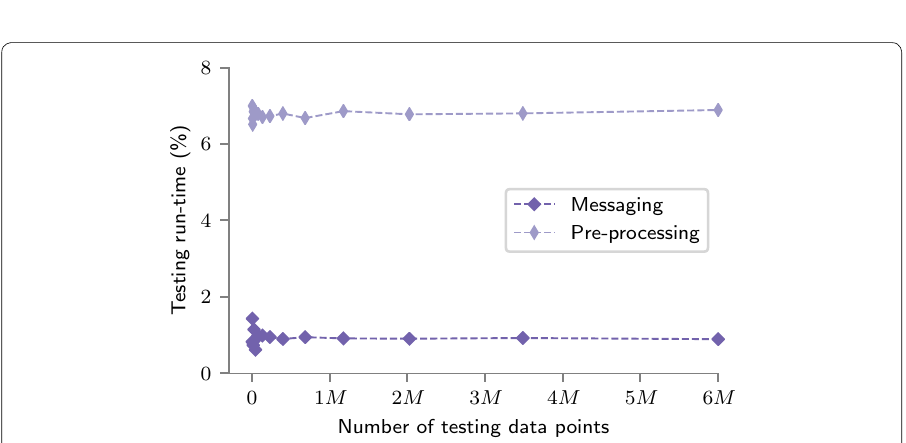
Fig. 28 Messaging and pre-processing. Run-time of message communications and pre-processing measured in percentage of the testing